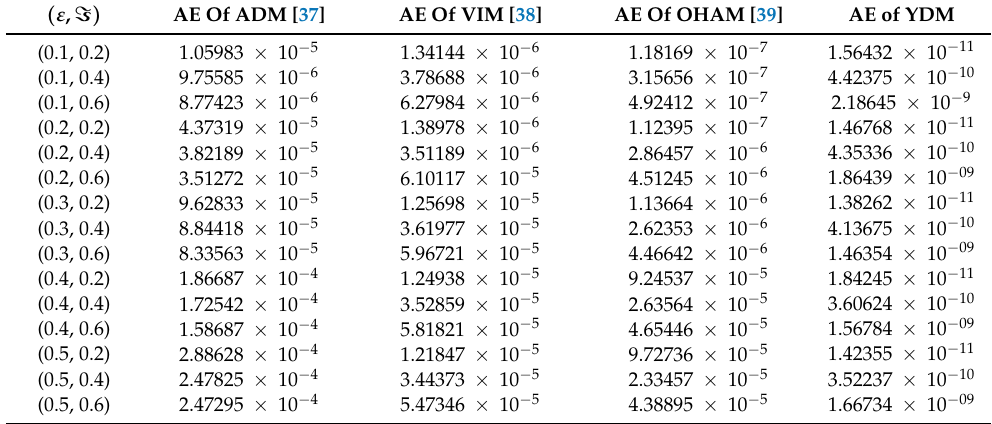
Table 3. Comparison of absolute error (AE) of U ( ε , (cid:61) ) at ℘ = 1 obtained by various methods.